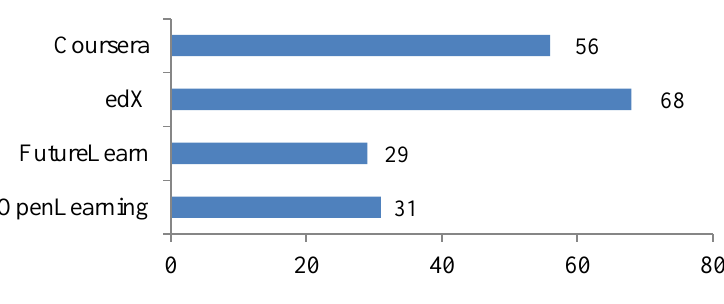
Figure 3 Average video length per study week